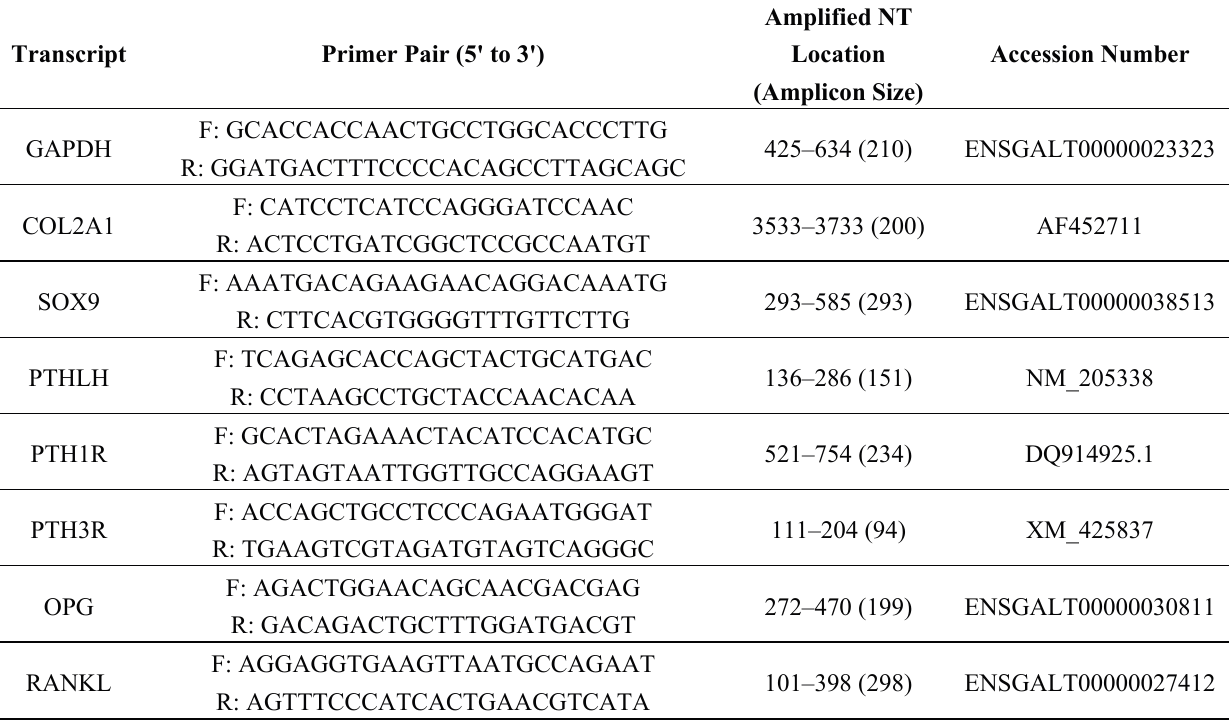
Table 1. Primers used during QRT-PCR. NT, nucleotide.